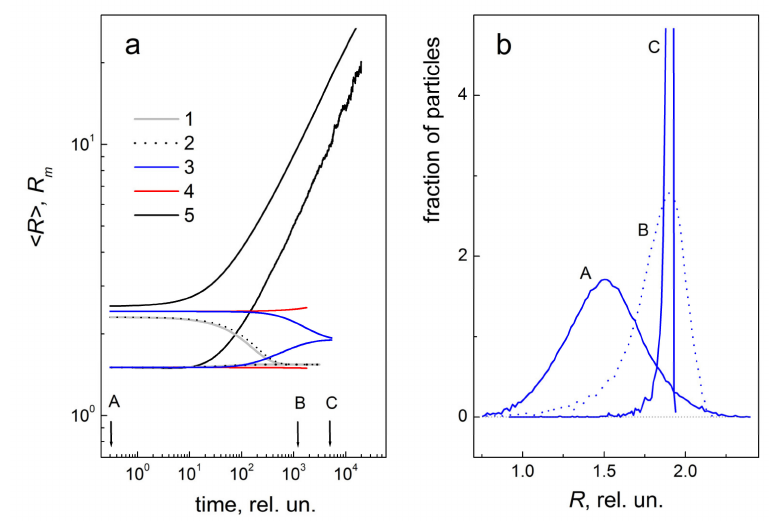
Figure 2. ( a ) Time evolution of the mean (cid:104) R (cid:105) and maximum R m radii calculated for an ensemble of 10 4 particles with Gaussian initial distribution ( (cid:104) R (cid:105) = 1.5 and standard deviation σ = 0.25) obtained via numerical solution of Equations (4)–(7) for T = 0.032 eV (100 ◦ C), γ 0 = 0.1 eV, ε = 0.4 eV and n S ≈ 0.002. The values of ε AB and γ 1 , respectively, are (eV units): (1) 0.24 and 0; (2) 0.21 and 0; (3) 0.21 and 0.01; (4) 0.196 and 0; (5) 0.18 and 0. ( b ) Particle size distribution (PSD) corresponding to the curves (3) at the time moments indicated by arrows in ( a